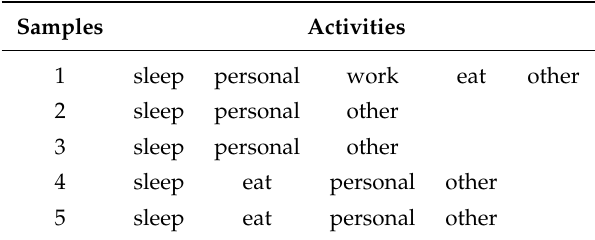
Table 2. A set of recorded samples for a particular context.